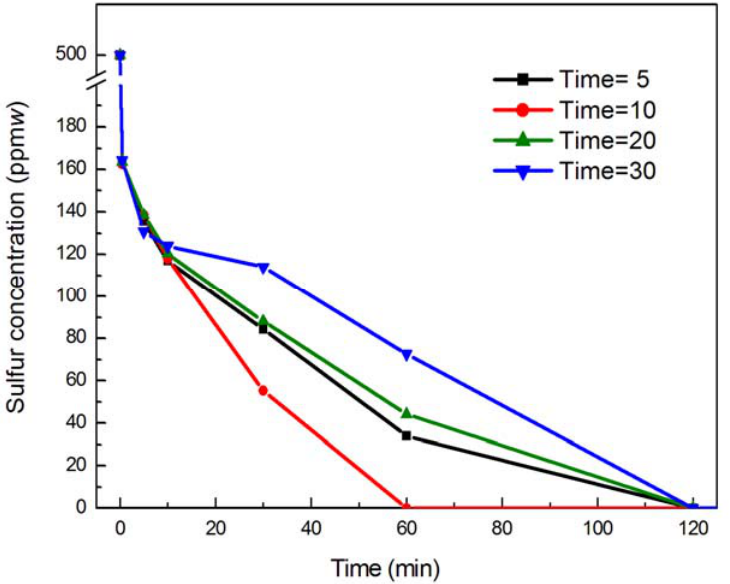
Figure 2. The effect of the pre-reaction time of H conditions: temperature 60 °C; O/S molar ratio 20; the amount of catalyst used was 1% the mass of n -octane; and DBT (S: 500 ppm( w ) in n -octane).